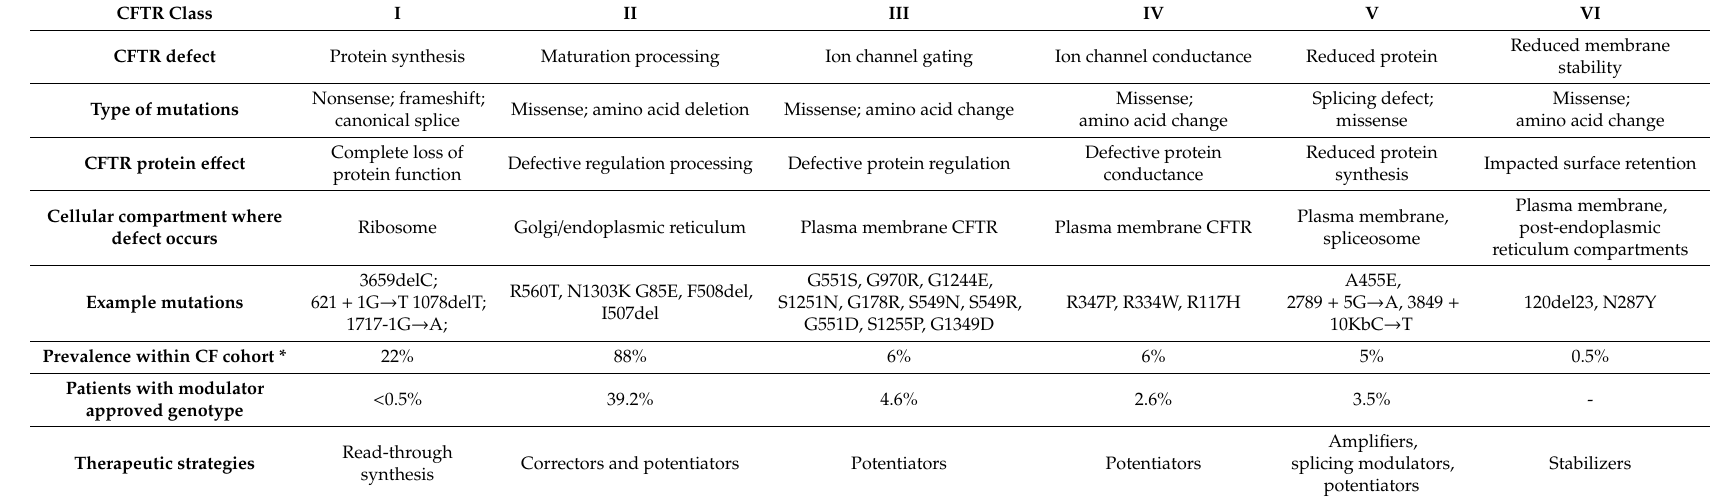
Table 1. Classification of cystic fibrosis transmembrane conductance regulator (CFTR) mutations and therapeutic